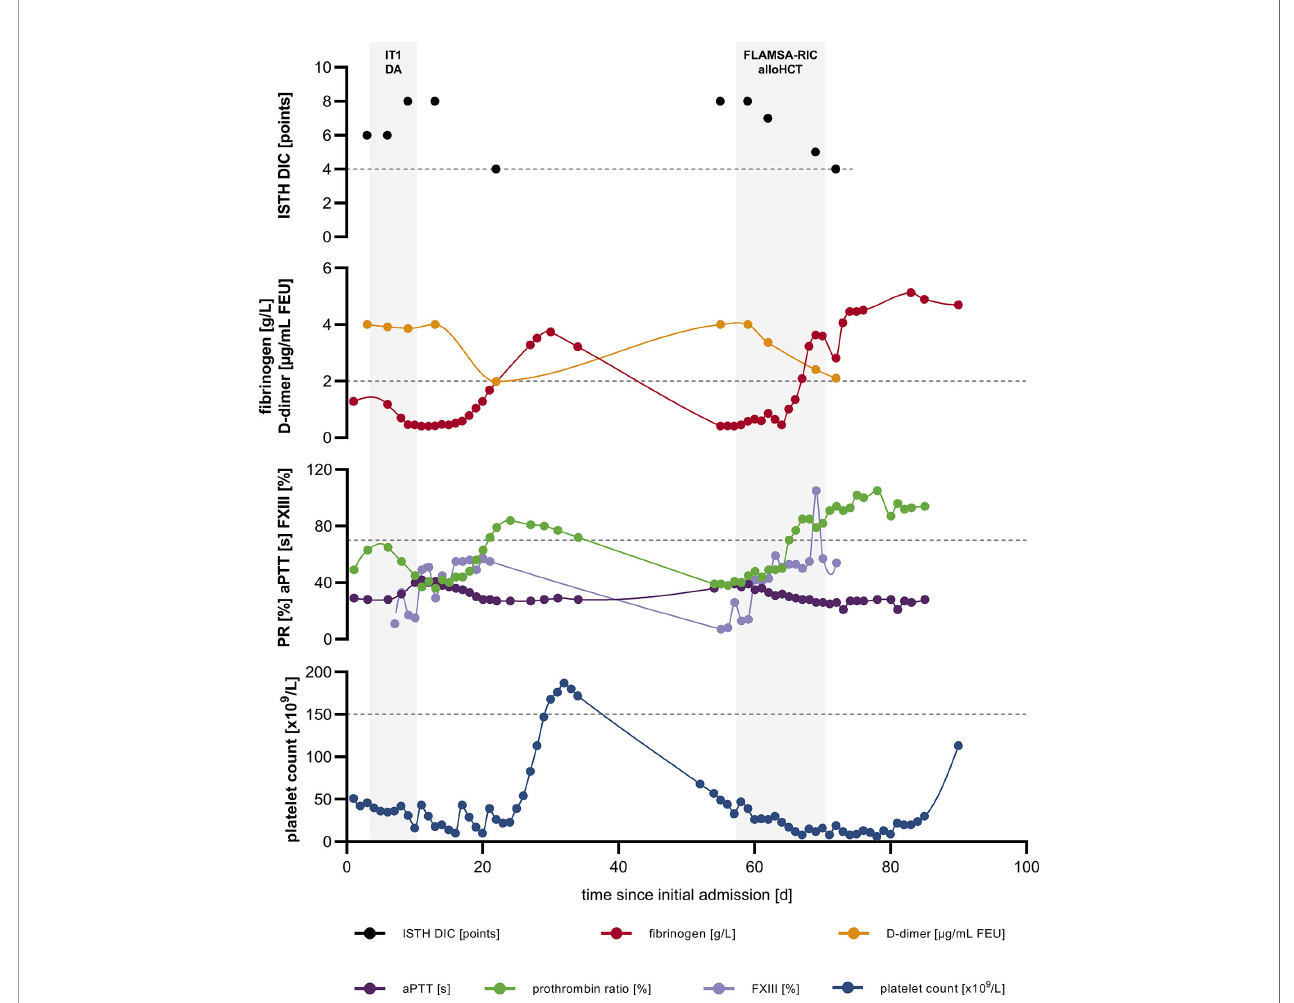
FIGURE 1 | Severe, recurring coagulopathy with hyper fi brinolysis. ISTH DIC score; fi brinogen and D-dimer levels; PR, aPTT and FXIII as well as platelet count over time; dashed lines indicate upper limit of normal (ULN) for ISTH DIC score and lower limit of normal (LLN) for fi brinogen, PR, platelet count, respectively. alloHCT, allogeneic hematopoietic cell transplantation; aPTT, activated partial thromboplastin time; DIC, disseminated intravascular coagulation; FLAMSA-RIC, sequential conditioning regimen ( fl udarabine, amsacrine and cytarabine followed by fl udarabine, busulfan and anti-thymocyte globulin); FXIII, factor XIII activity; IT1 DA, induction chemotherapy: daunorubicin and cytarabine; ISTH, International Society on Thrombosis and Haemostasis; PR, prothrombin